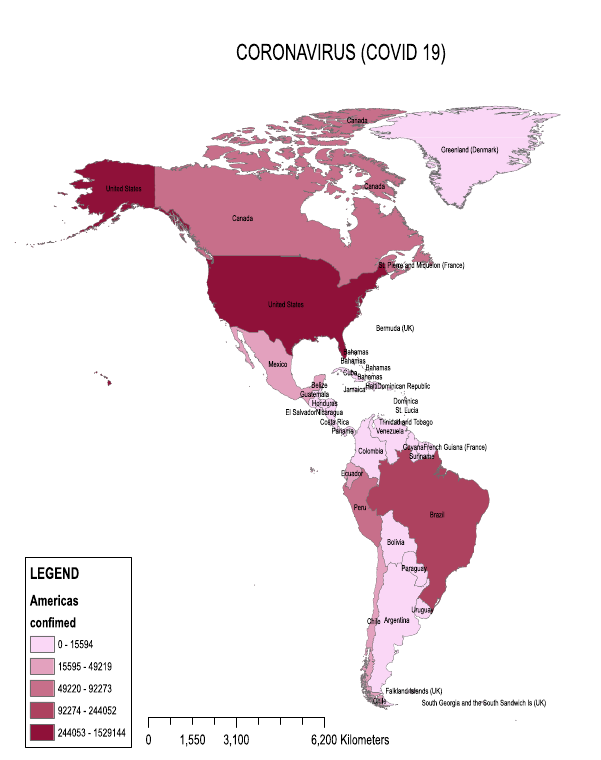
Fig. 3. Spatial distribution of confirmed cases in the Americas.